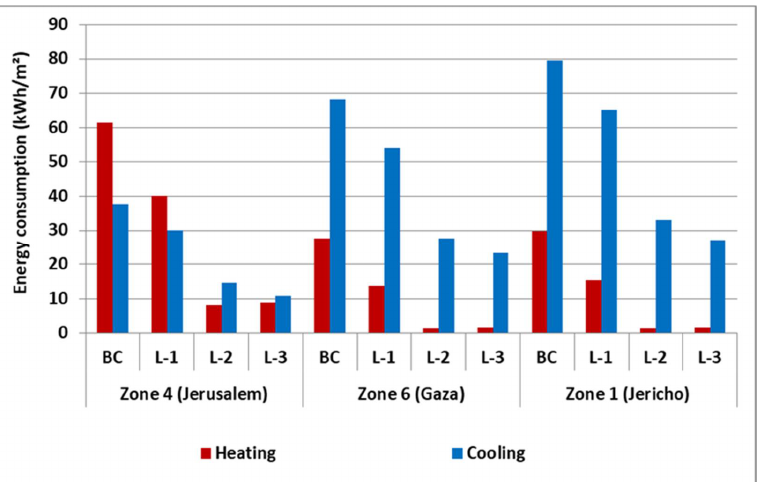
Figure 4. Saving in energy for heating and cooling from applying the retrofit plan on buildings with two residential units per floor area in different climatic zones in Palestine. For the residential buildings with four units per floor buildings, the simulation re- sults show that applying level 1 of the retrofit plan can reduce the annual total energy by 24% and 23% compared with the base case building for climatic zones 4 and 6 (from 127.2 kWh/m 2 to 96.6 kWh/m 2 and from 126.2 kWh/m 2 to 97.0 kWh/m 2 , respectively), and by 22% for climatic zone 1 (from 138.1 kWh/m 2 to 107.9 kWh/m 2 ). This reduction was slightly higher than the reduction for two residential units per floor type. By applying the combi- nation of level 1 and level 2 of the retrofitting plan, the reduction in total energy compared to the base case was 56%, 50%, and 51% for Zones 4, 6, and 1, respectively, which is very close to two residential units per floor type. Finally, applying the three levels of the retro- fitting plan can result in a total reduction in total energy compared with the base case by 80% for zone 4 and 73% for zones 6 and zone 1 as can be seen in Table 2, which is higher than the reduction for two residential units per floor type. Table 2. Results from the simulation for energy consumption for lighting, heating, cooling, and domestic hot water, com- paring the base case scenario with the three-level retrofit plans for buildings with four units per floor area. Climate Zone/City Retrofit Plan